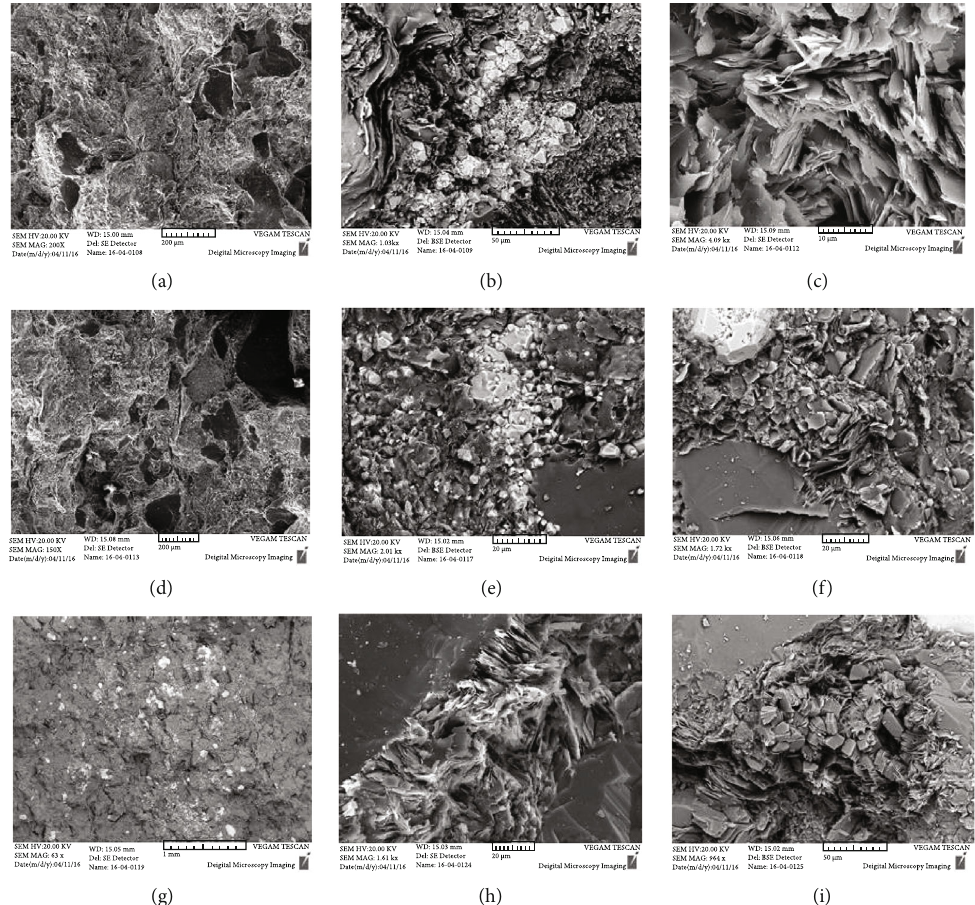
Figure 4: SEM results of three tight gas sandstone samples: (a) full microscopic view of tight gas, interparticle pores ranging 1-5 microns (LX3); (b) di ff erent stages of pyrite aggregation and platey biotite (LX3); (c) platey and fi lamentous illite with pore ranging around 1-3 microns (LX3); (d) full microscopic view of tight gas, interparticle pores ranging around 1-5 microns and poor connectivity (LX1); (e) di ff erent stages of pyrite distributed on the surface of the particles (LX1); (f) platey kaolinite fi lling interparticle pore (LX1); (g) full microscopic view of tight gas with rich white pyrite (LX2); (h) platey illite fi lling interparticle pores and forming 2-4 micron pores (LX2); (i) thick platey dickite and fi lamentous illite fi lling interparticle pores